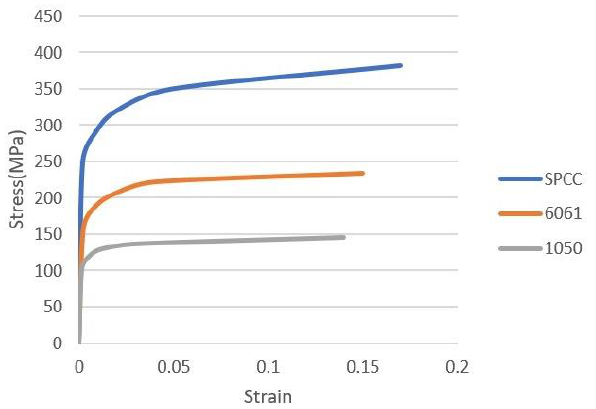
Figure 3. Stress-strain curves of Al 1050, Al 6061, and SPCC steel.